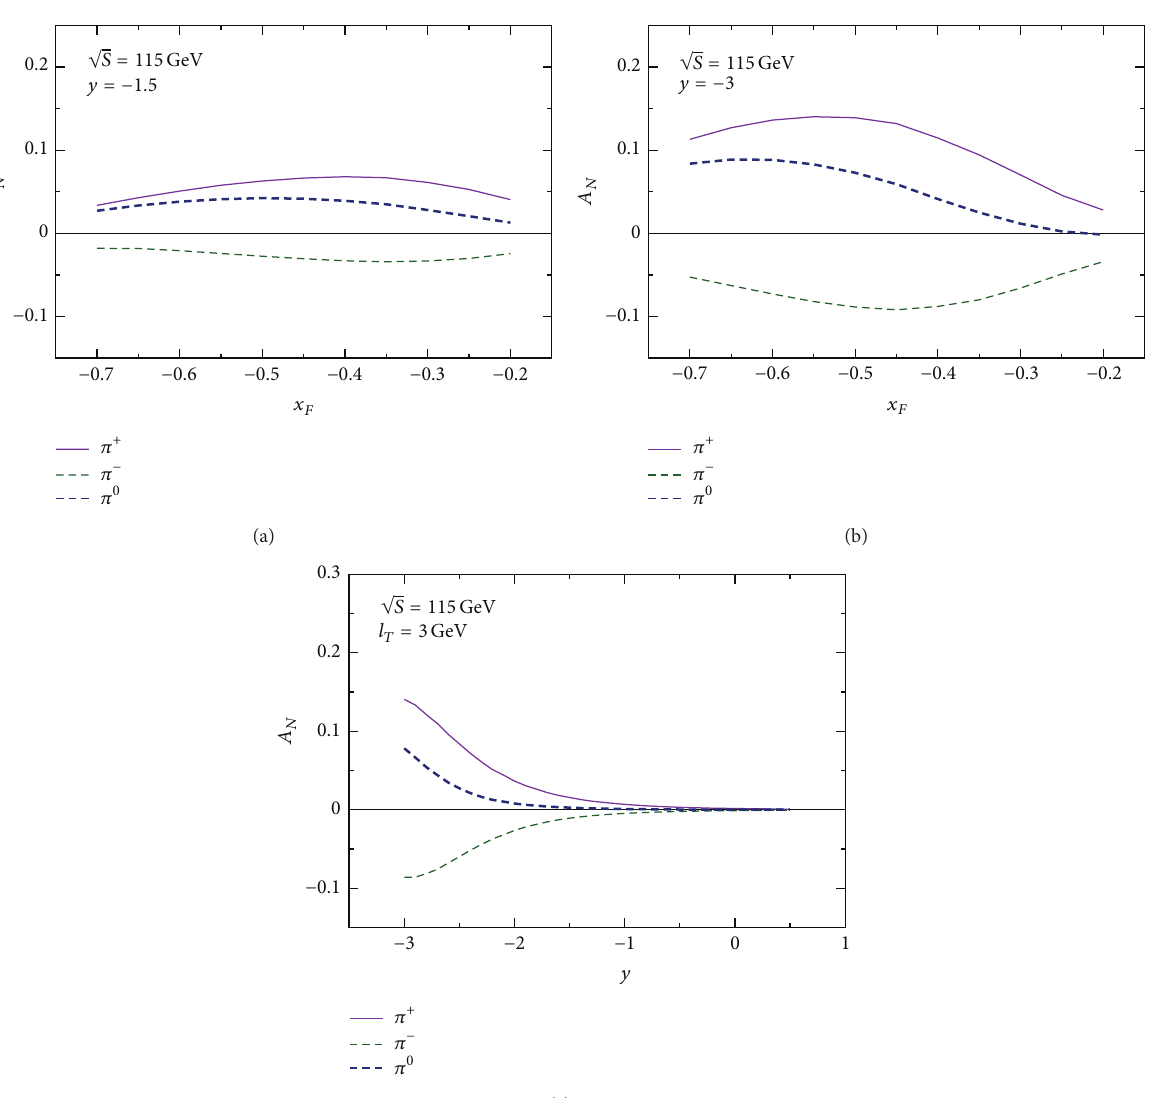
Figure 1: 𝐴 𝜋 𝑁 versus 𝑥 𝐹 at fixed 𝑦 = −1.5 (a) and 𝑦 = −3 (b) and 𝐴 𝜋 𝑁 versus 𝑦 at fixed 𝑙 𝑇 = 3 GeV (c). All plots are at √𝑆 = 115 GeV for pion production at